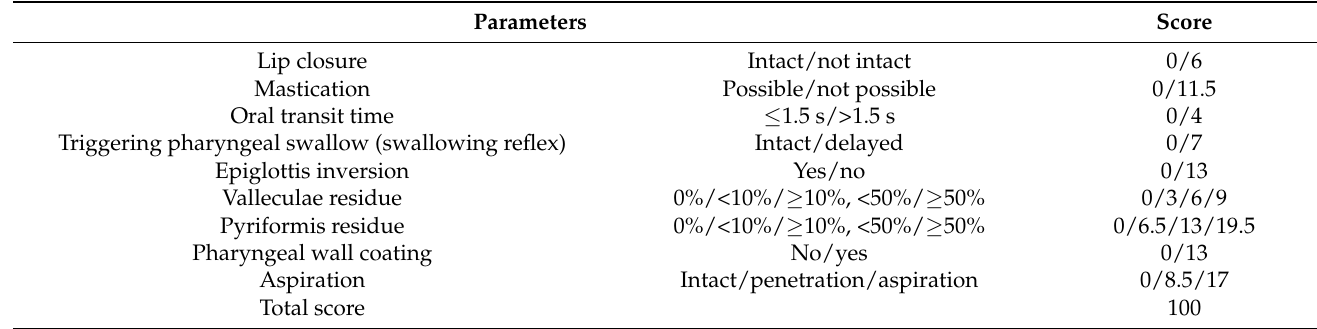
Table 1. Modified version of the videofluoroscopic dysphagia